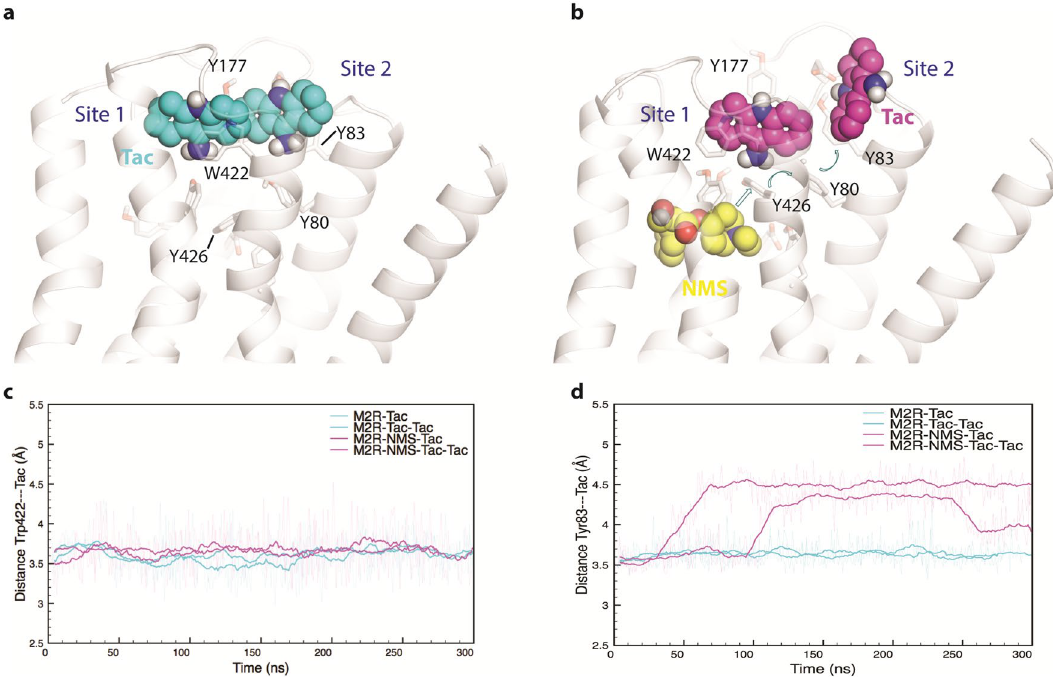
Figure 5. Molecular dynamics of tacrine at the M 2 receptor. ( a , b ) The most frequently observed poses adopted by tacrine at the allosteric site are shown for a monomer of the wild-type receptor in which the orthosteric site is vacant ( a ) or occupied by NMS ( b ). In the otherwise vacant receptor, two molecules of tacrine (cyan) occupy two sites defined by interactions with Tyr 177 and Trp 422 (Site 1) and with Tyr 80 and Tyr 83 (Site 2). In the receptor occupied by NMS (yellow), the disruption of Site 2 forces a different and unstable orientation of tacrine in that site while having little effect on the binding of tacrine at Site 1 (purple). These computations were performed using PyMOL (The PyMOL Molecular Graphics System, Version 2.0 Schrödinger, LLC; http:// www. pymol. org/) ( c ) The stability of tacrine at Site 1 was monitored as the distance from center to center between the pyridine ring of tacrine and the indole ring of Trp 422(7.35) , which did not change over the production period of 300 ns. ( d ) The stability of tacrine at Site 2 was monitored as the distance from center to center between the pyridine ring of tacrine and the phenyl ring of Tyr 83(2.64) . Tacrine adopts a stable pose at Site 2 when the orthosteric site is vacant, but the interaction is destabilized in the presence of NMS. Figures ( c , d ) were produced in Plot2 version 2.6.11 (https:// apps. micw. org/ apps/